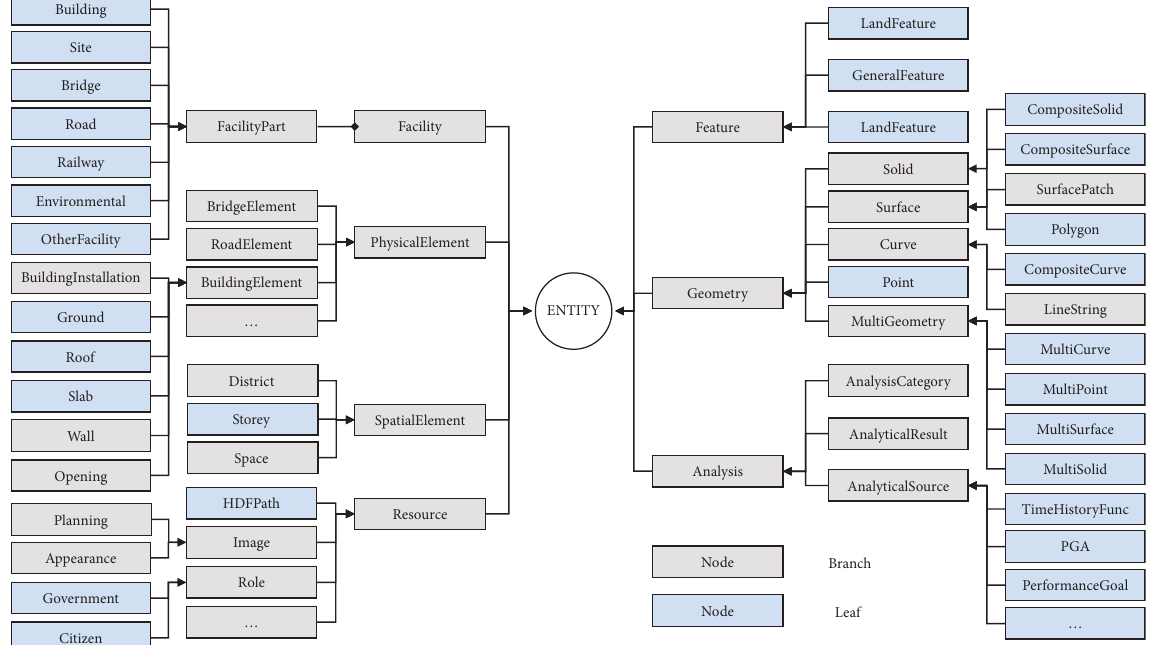
Figure 18: The experimental urban ontology designed to aggregate information from the transformed